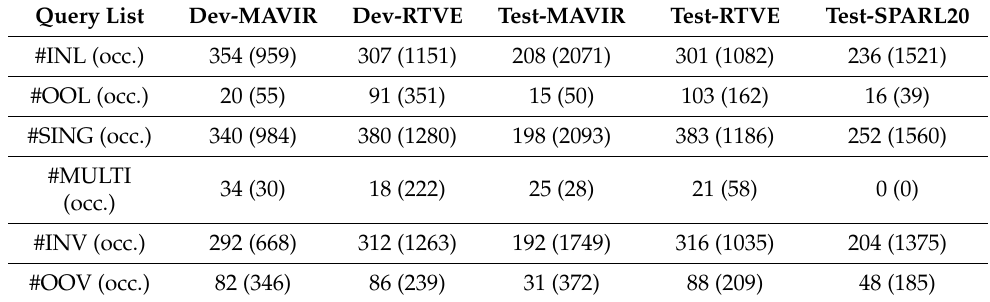
Table 4. Development and test query list characteristics for the MAVIR, RTVE and SPARL20 databases for the STD task. ‘dev’ stands for development, ‘INL’ refers to in-language queries, ‘OOL’ to foreign terms, ‘SING’ to single-word queries, ‘MULTI’ to multi-word queries, ‘INV’ to in-vocabulary queries, ‘OOV’ to out-of-vocabulary queries and ‘occ.’ stands for occurrences. The term length of the development query lists varies between 4 and 27 graphemes. The term length of the MAVIR and RTVE test query lists varies between 4 and 28 graphemes. The term length of the SPARL20 test query list varies between 3 and 19